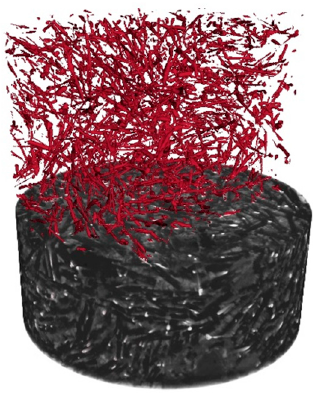
Figure 9. Visualization of the morphology of the metal-rich phases of sample S.